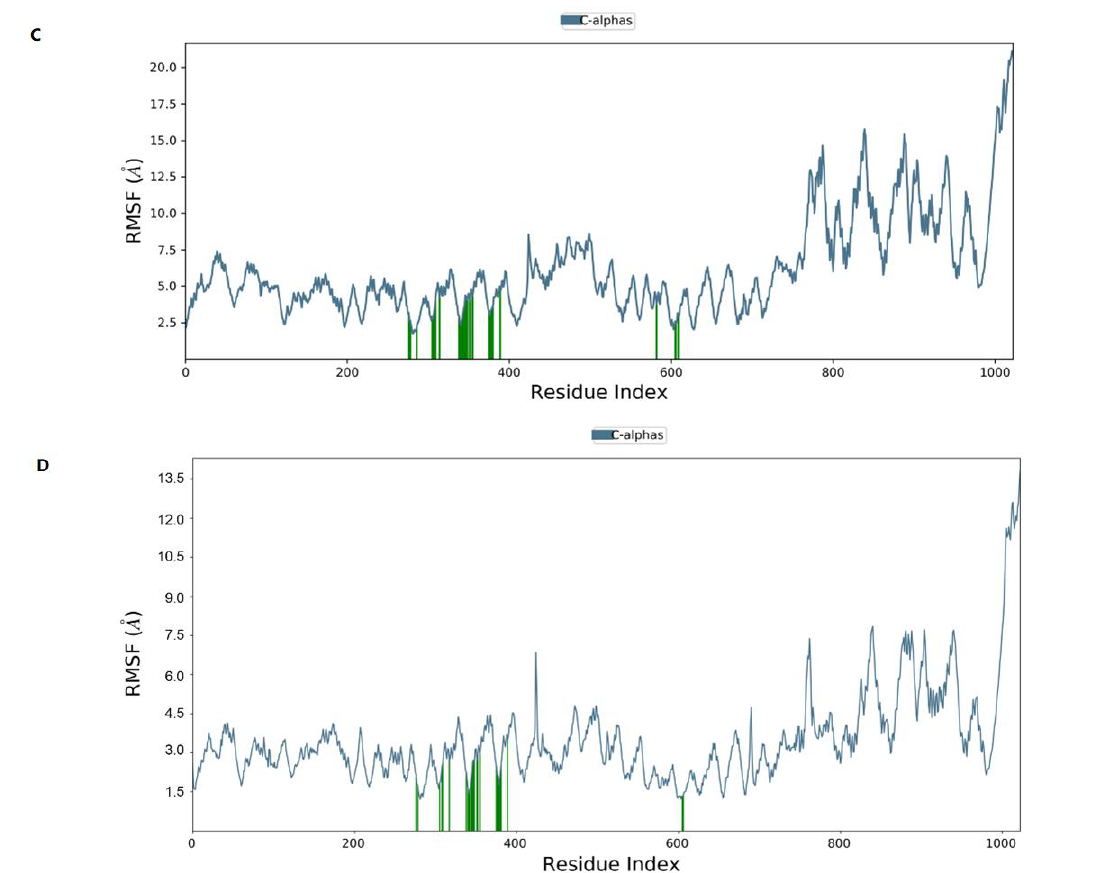
Figure 7. The MD studies of ligands binding to ACLY ( A ); the RMSD plot for ACLY and herbacetin or NDI–091143 ( B ); complex ( C ); the RMSF plot of ACLY chain in the presence of herbacetin or NDI–091143 ( D